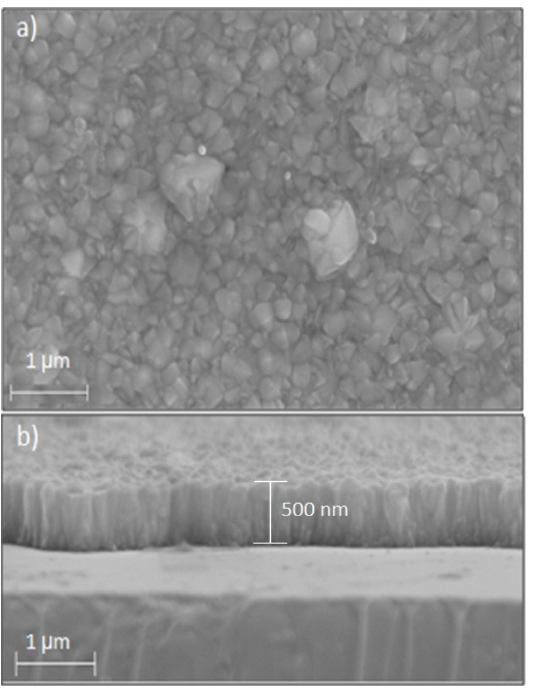
Fig. 2. Scanning electron microscopy (SEM) studies of the starting SnO :F sensing film: (a) Surface and (b) tilted cross section. 2